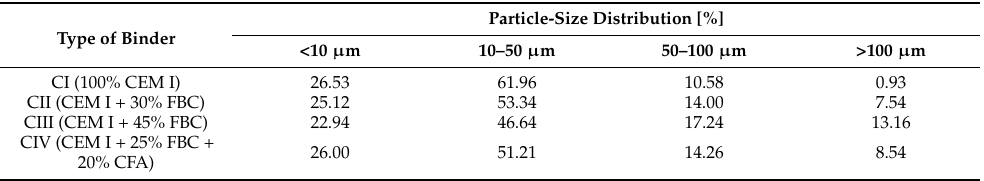
Figure 4. Particle-size distribution of cement–fly-ash binders. Table 5. Particle-size distribution of cement–fly-ash